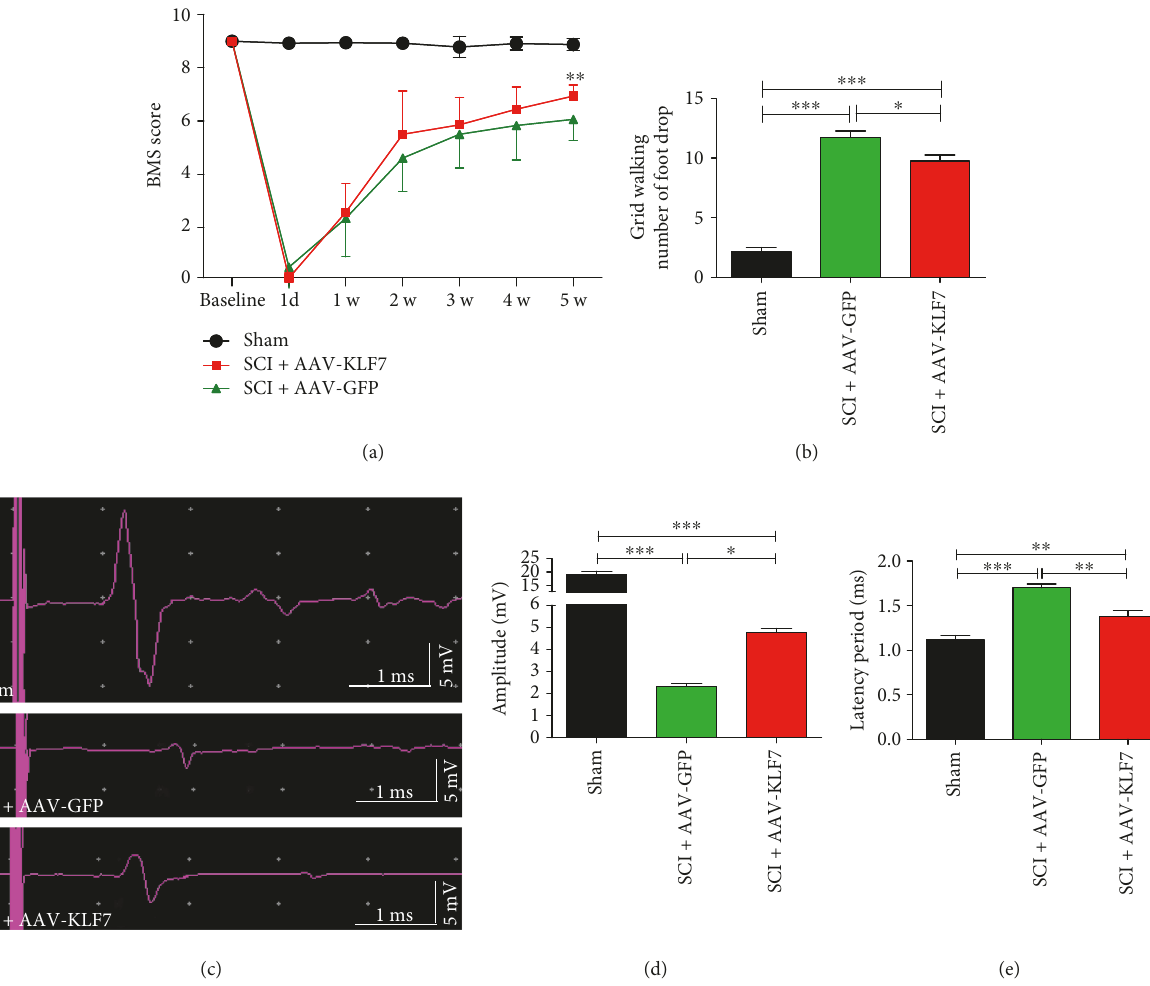
Figure 14: AAV-KLF7 signi fi cantly enhanced motor functional recovery following SCI. (a) Quantitative analyses of the Basso Mouse Scale (BMS) locomotor scores post-SCI (b), number of foot drops during grid walking fi ve weeks postinjury (c), and tcMMEP responses fi ve weeks postinjury (d), including the amplitude (mV) (e) and latency period (ms) from each group ( n = 8 ), are shown. Error bars denote SD. ∗ P < 0 05 , ∗∗ P < 0 01 , and ∗∗∗ P < 0 001 , one-way ANOVA, Tukey ’ s post hoc